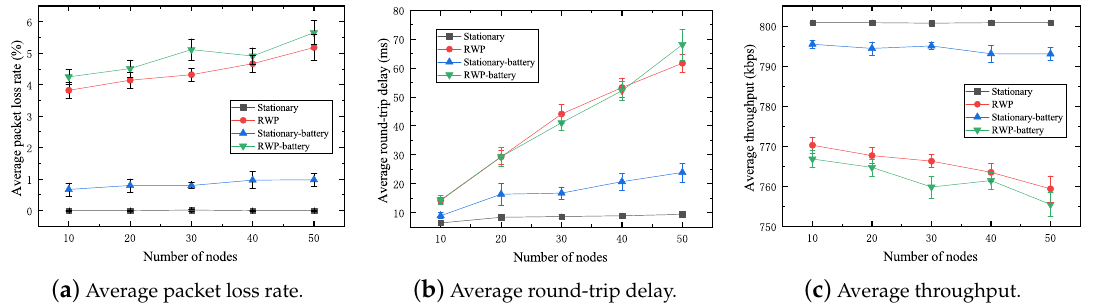
( b ) Average round-trip delay. ( c ) Average throughput. Figure 5. Performance impact of random waypoint